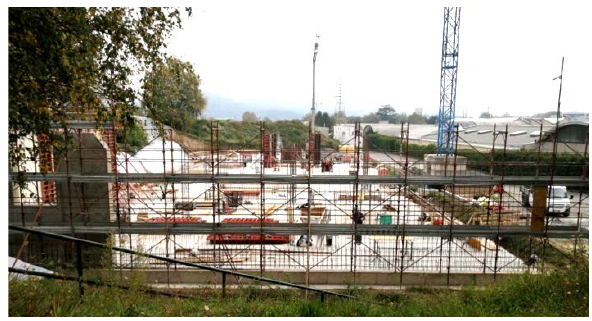
Figure 2. Construction site as of